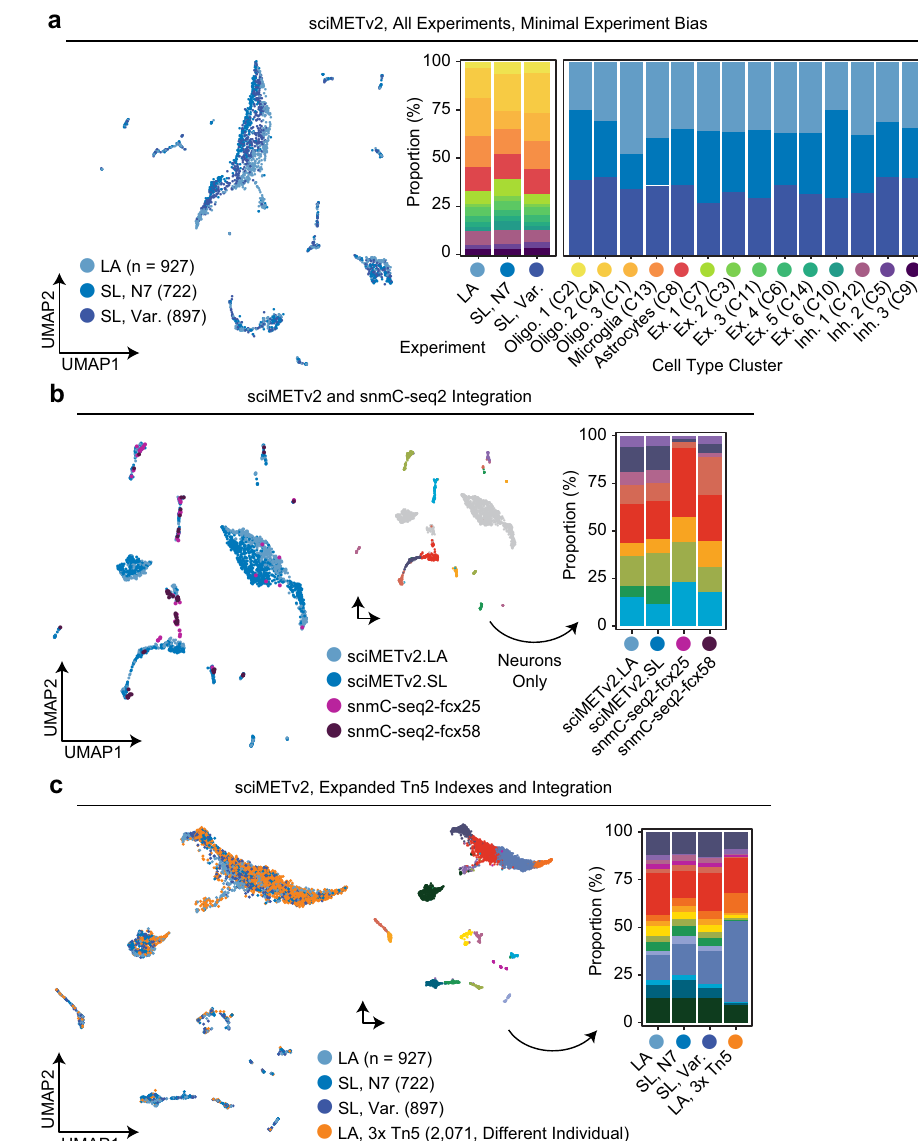
Fig.6|Assessmentofbiasbetweenexperimentsandtechnologies.a Integrated UMAP colored by sciMETv2 experiment (left) and the cluster breakdown for each experiment as wellasexperimentbreakdownforeachcluster(right). b Integration with human frontal cortex snmC-seq2 data projected into a UMAP and colored by assay (left), and by clusters (middle, non-neuron clusters are grayed out), with the